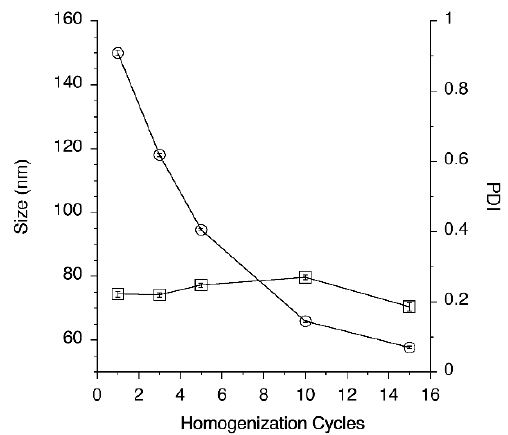
Figure 2. Effect of the number of homogenization cycles on nanoemulsion droplet size (empty circles) and PDI (empty squares).